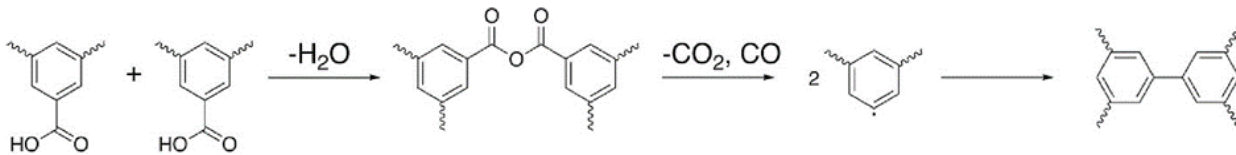
Figure 9. Thermal crosslinking mechanism of 6FDA-DABA. Adapted from [93] with permission. Copyright (2019) Else- vier.